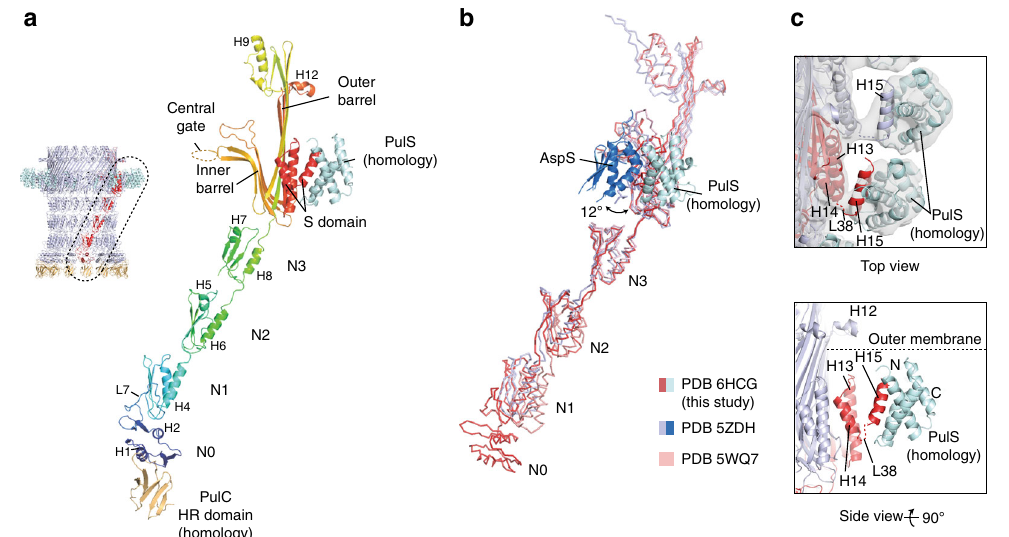
Fig. 4 Structural comparison of PulD and PulS models. a A complex of PulD, PulS and PulC HR domain monomers extracted from the C15 OMC model (dotted region). For PulD, rainbow colouring highlights blue N-terminus through to red C-terminus. b Superposition of the PulD and PulS complex with the equivalent from enterotoxigenic E. coli PDB 5ZDH and E. coli K12 PDB 5WQ7. Compared with PulD, these PDBs differ by RMSD C α = 3.3 and 3.2 Å, respectively. The relative position of AspS in PDB 5ZDH differs to PulS by a 12° azimuthal rotation around the secretin long axis. c (Top) Fit of PulS homology model with the OMC map. The map was low pass fi ltered to 8 Å and contoured at 5 σ before rigid body fi tting. (Bottom) Cartoon schematic showing the PulS model relative to the PulD S-domain (red helices). PulD helix 15 locates to a groove within PulS 30 . Flexible loop 38 represents the only attachment between the helix 15/PulS complex and the rest of the PulD monomer.